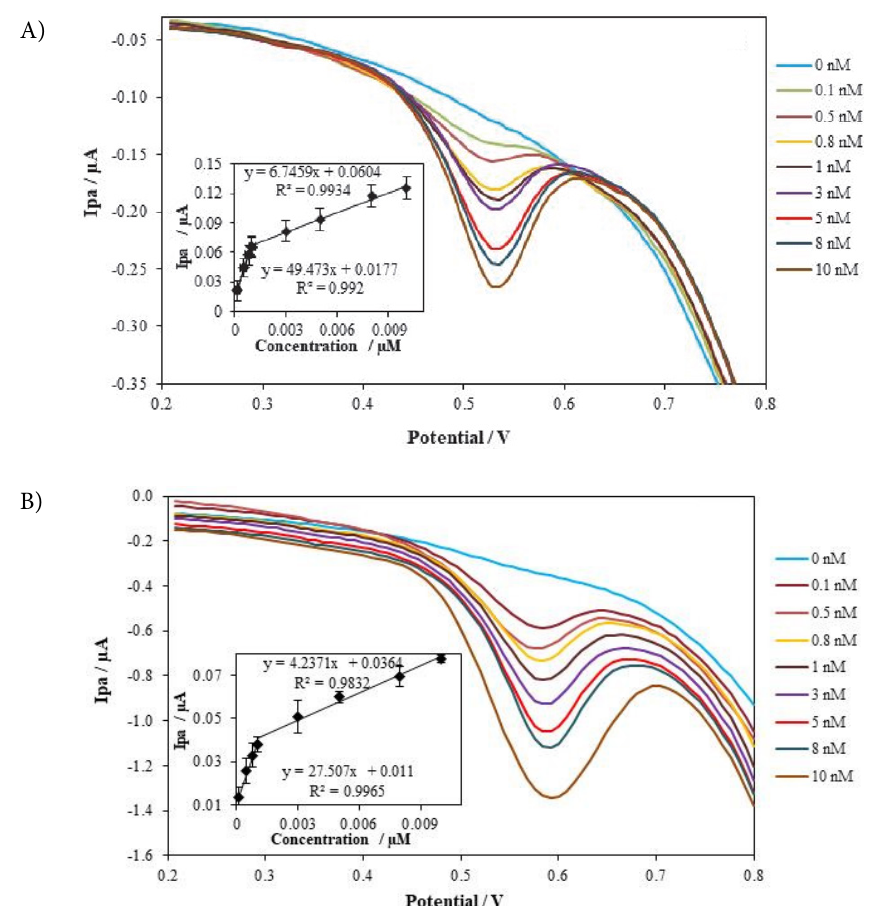
Figure 8. A. AdsDPV and B. AdsSWV voltammograms recorded in 0.04 M BR buffer (pH 9.0) for increasing KC concentrations under optimized conditions. Inset: Calibration graphs for KC.